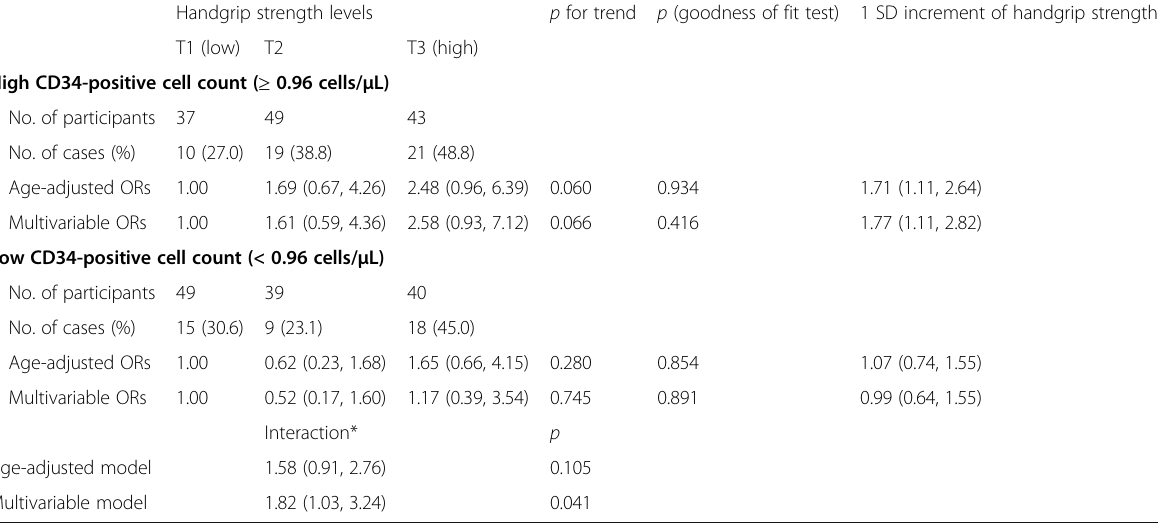
Table 4 Odds ratios (ORs) and 95% confidence intervals (CIs) for diastolic hypertension in relation to handgrip strength stratified by circulating CD34-positive cell count Handgrip strength